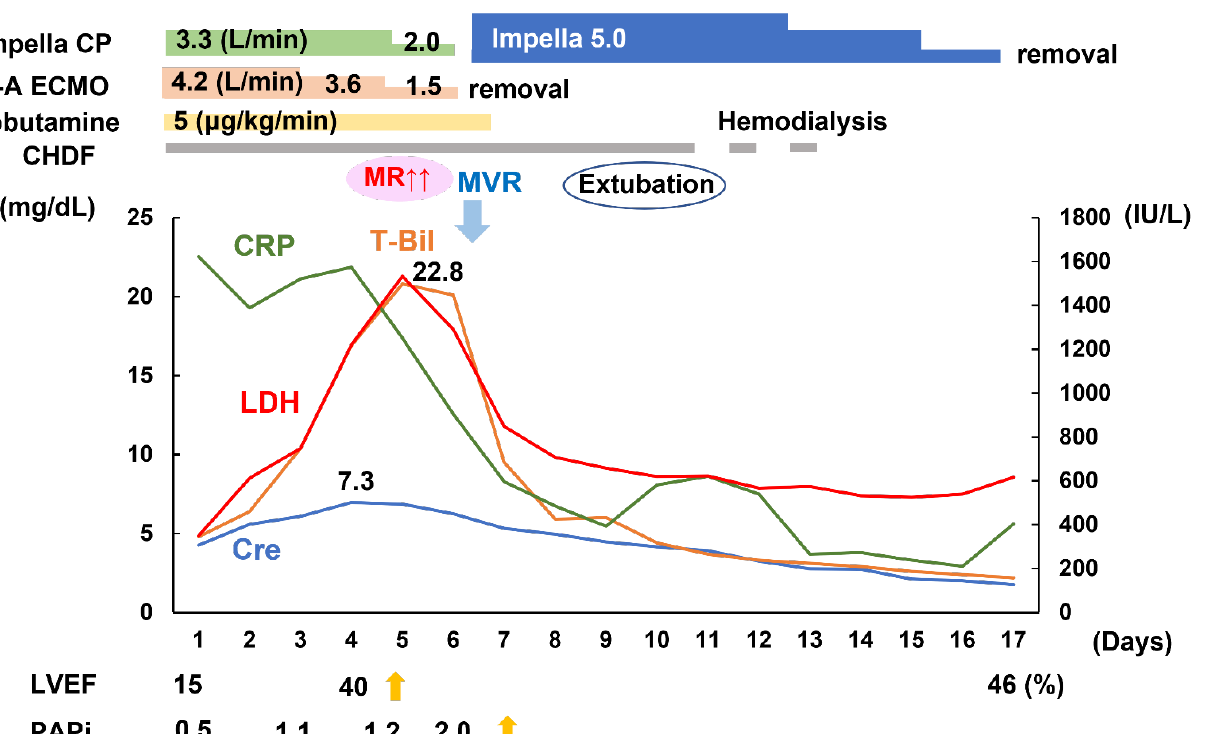
Figure 2. Clinical course after initiation of veno-arterial ECMO and Impella supports. CRP, C-reactive protein; LDH, Lactate dehydrogenase; T-Bil, Total bilirubin; Cre, Creatinine, LVEF, left ventricular ejection fraction; PAPi; Pulmonary artery pulsatility index; V-A ECMO, Veno-arterial extracorporeal membrane oxygenation; CHDF, continuous hemodiafiltration; MR; Mitral valve regurgitation; MVR; Mitral valve replacement.